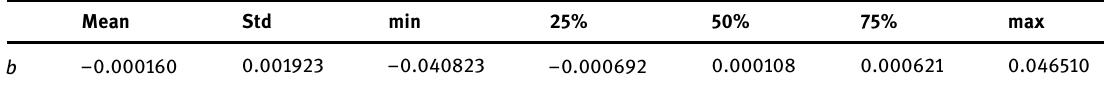
Table 1: Summary statistics for autoregressive model from Eq. ( 1 ) , all networks Mean